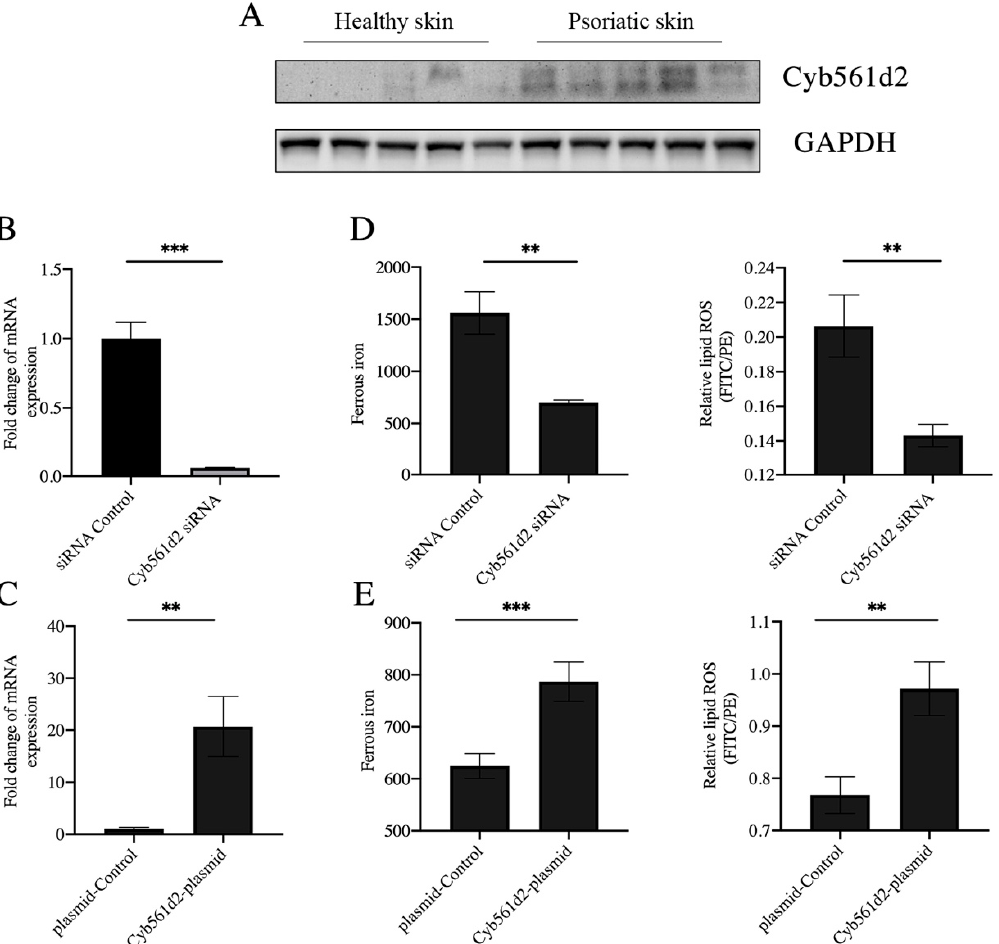
Figure 4. Level of lipid ROS and iron in HaCaT cell. ( A ) Protein level of Cyb561d2 measured by Western blot in psoriatic skin lesions ( n = 5) and normal controls ( n = 5). ( B ) Test for knockdown efficiency of Cyb561d2 siRNA in HaCaT cells. ( C ) Test for overexpression efficiency of Cyb561d2 plasmid in HaCaT cells. ( D ) Levels of intracellular ferrous iron and levels of lipid peroxidation in HaCaT cells transfected with Cyb561d2 siRNA ( n = 3) and control siRNA ( n = 3). ( E ) Levels of intracellular ferrous iron and levels of lipid peroxidation in HaCaT cells transfected with DNA plasmid ( n = 3) and control plasmid ( n = 3). Data represent the mean ± SEM: ** p < 0.01, and *** p < 0.001. Two-tailed Mann–Whitney U test was used.